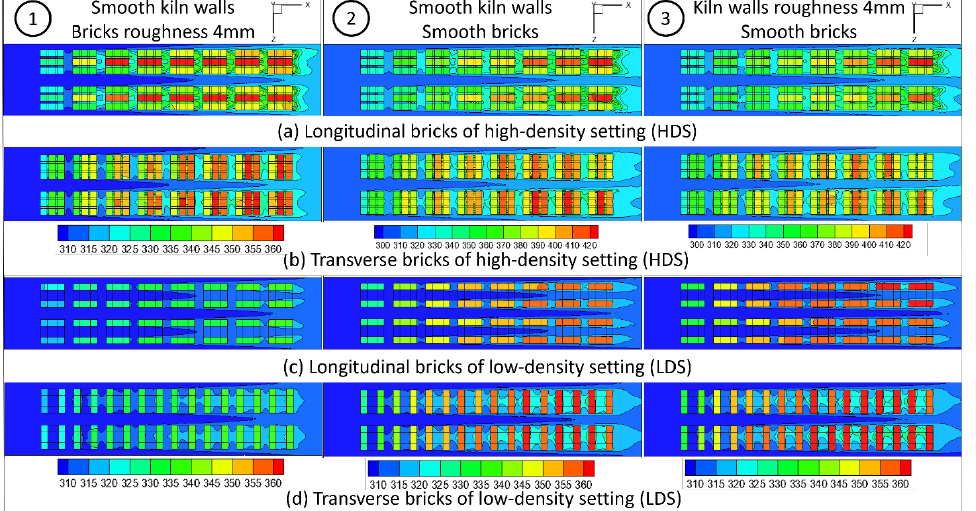
Figure 6. Comparison of the brick temperature contours in ( a ) longitudinal bricks for the high-density setting, ( b ) transverse bricks for the high-density setting, ( c ) longitudinal bricks for the low-density setting, and ( d ) transverse bricks for the low-density setting for (1) smooth kiln walls and rough bricks, (2) smooth kiln walls and bricks, and (3) rough kiln walls and smooth bricks.